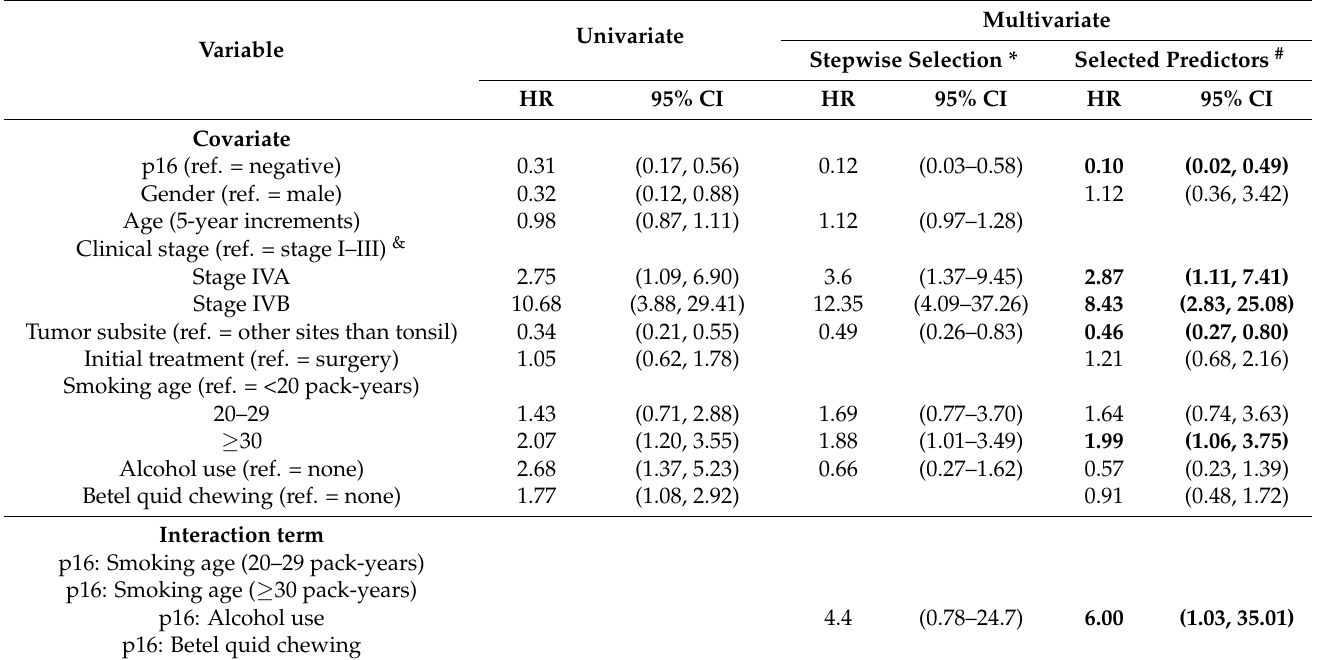
Table 3. Univariate and multivariate analyses for disease-free